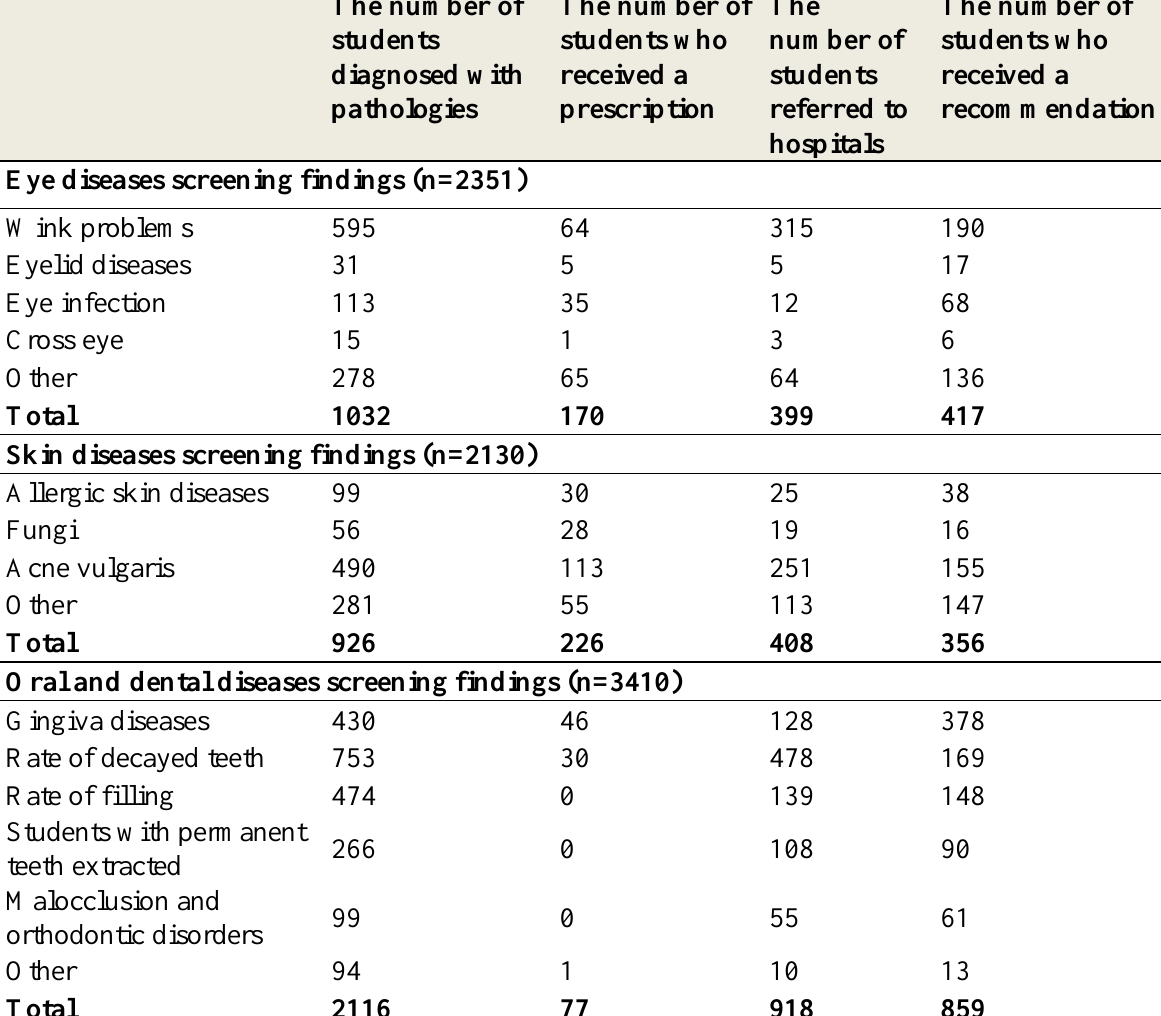
Table 2. Pathologies identified in examined